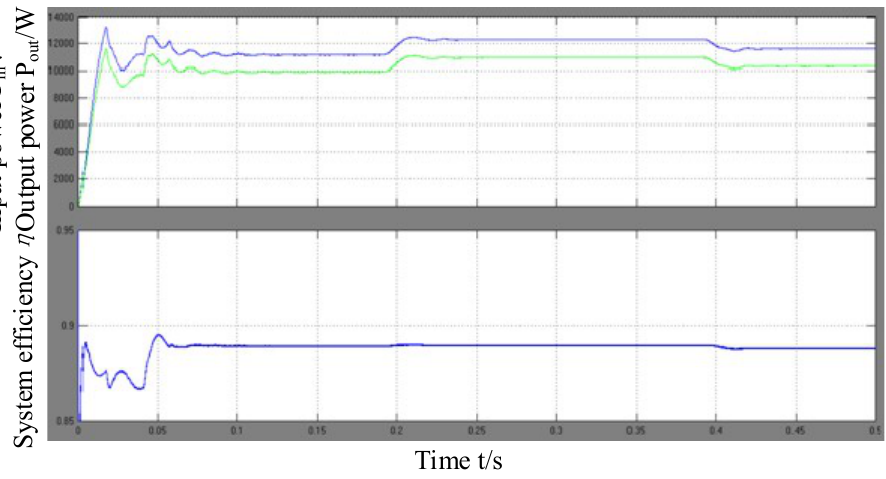
Figure 14. Power and efficiency waveform of constant current simulation of battery load.